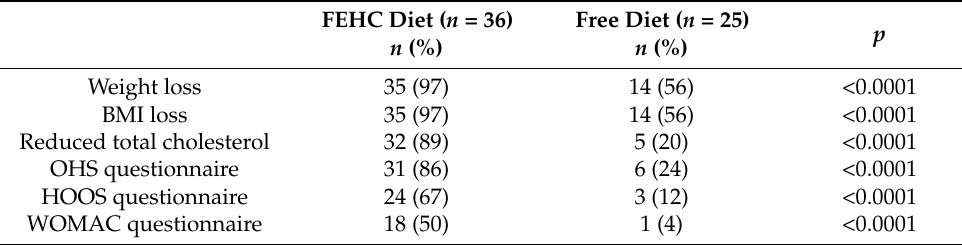
Table 3. Improvement in body parameters and questionnaire scores according to FEHC